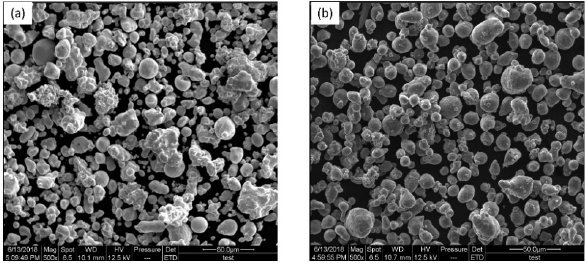
Figure 1. The morphology of ( a ) Cu powders and ( b ) Al powders.